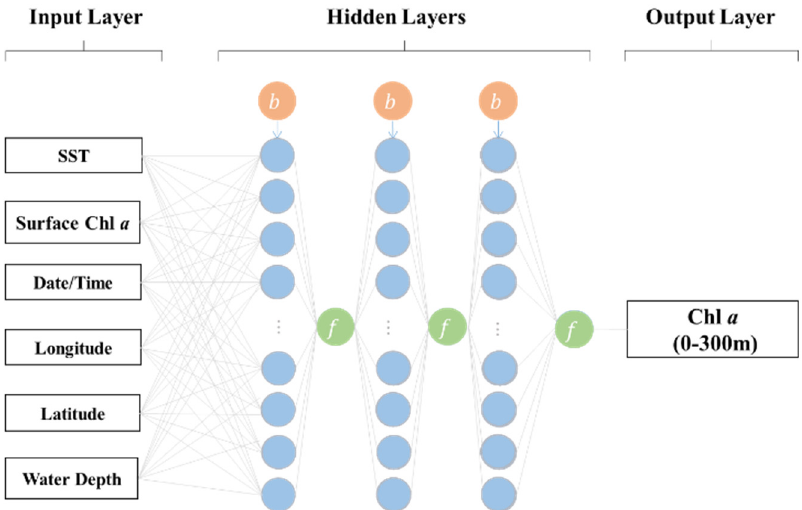
Figure 1. Structure of the deep neural network (DNN). The input elements of DNN are longitude, latitude, time, sea surface temperature (SST), sea surface Chl a , water depth. The output is the vertical distribution of Chl a concentration over the water depth of 0–300 m. b is the bias term in the hidden layer. The prior information of nonlinear activation function ( f ) connects the hidden layers to the output.